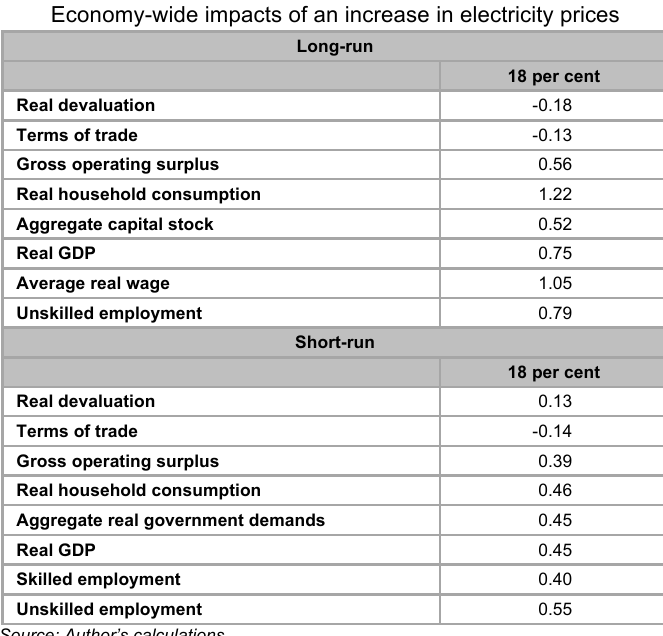
Economy-wide impacts of an increase in electricity